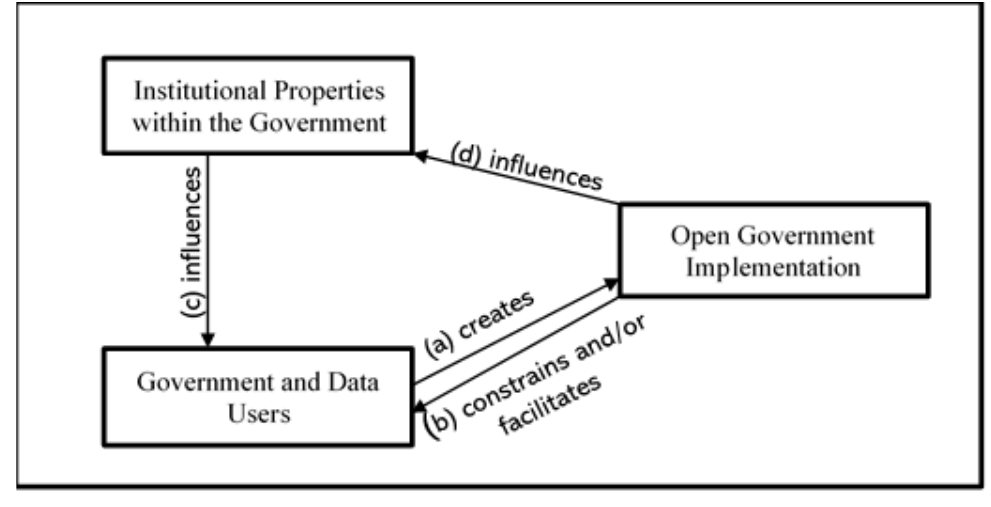
Figure 3. Proposed Structurational Model of Open Government Data – Ensuring Adoption of